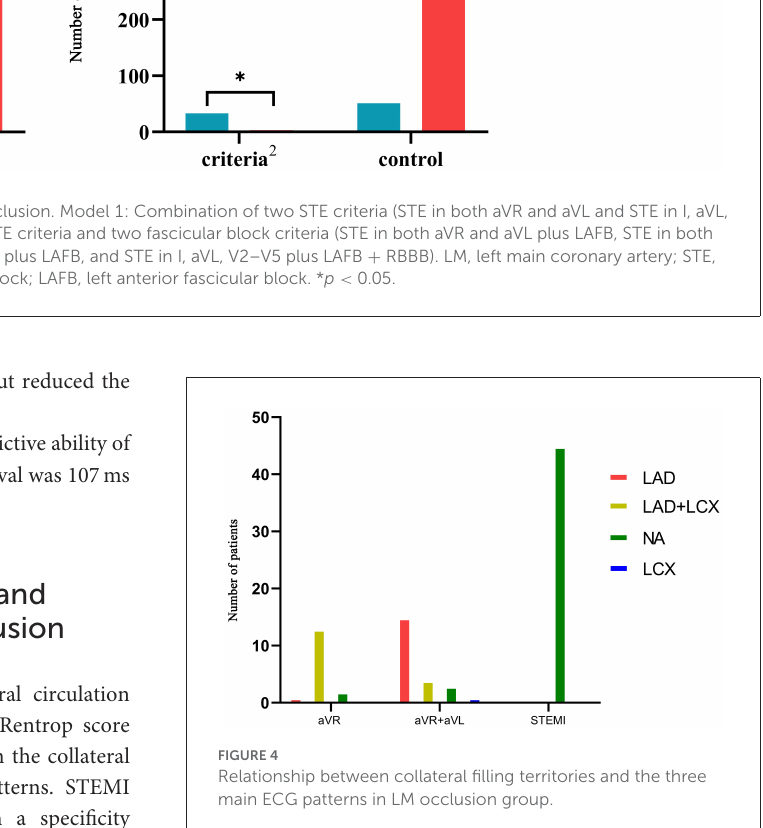
presentations caused by different collateral filling